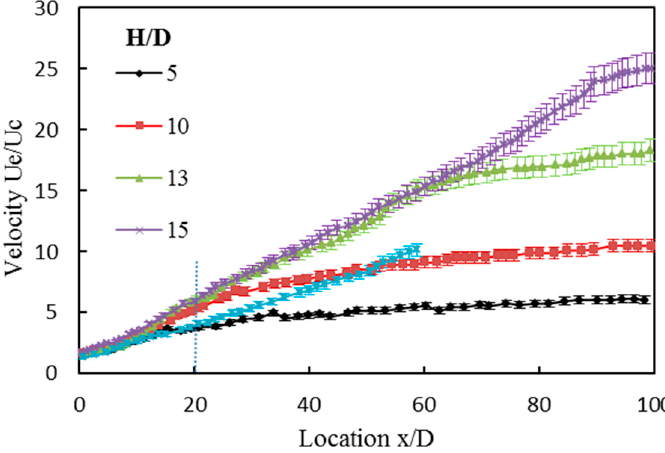
Figure 6. Distribution of centerline velocity in the axial direction.